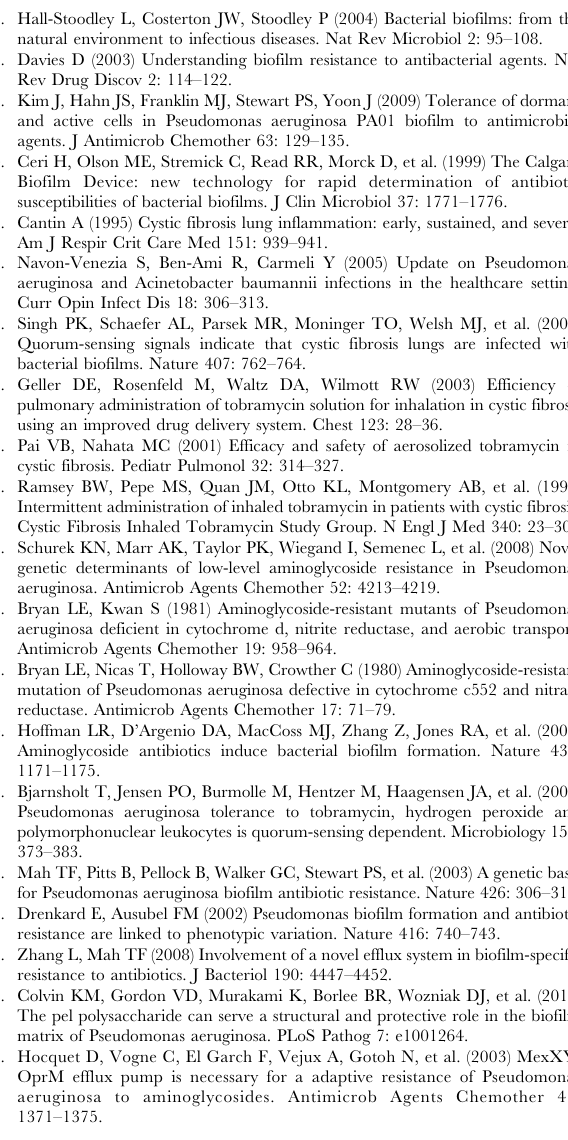
Table S2 Plasmid table. List of all plasmids used in this study. (XLS) Table S3 Summary of genes with altered fitness in the Bio-TOB assay that were subjected to further charac- terization. Shown are the PA # s, annotations, and predicted pathway of action (if available) for genes whose disruptions alters fitness in the Bio-TOB assays of Figure 3A and 3B.